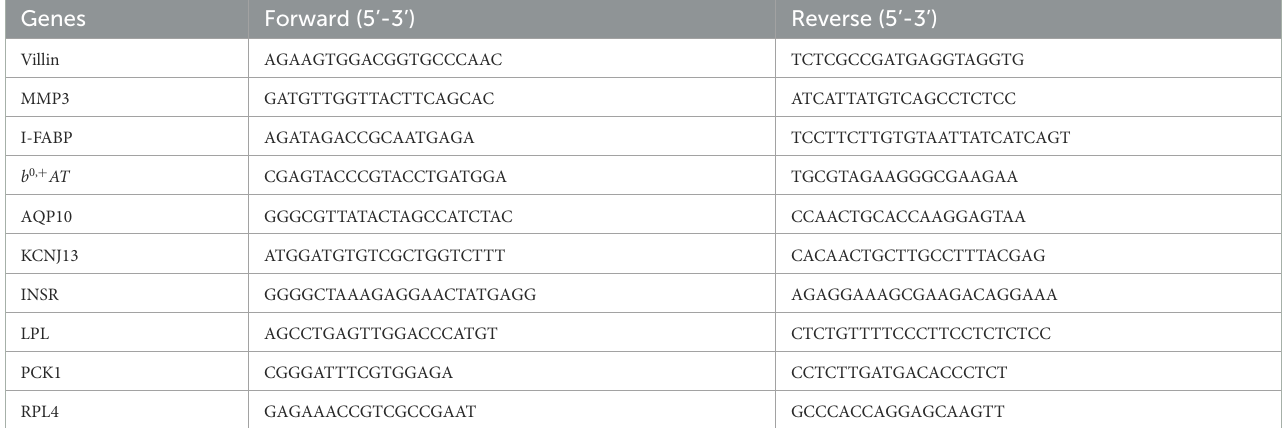
TABLE 2 Primer sequences used in the present study.